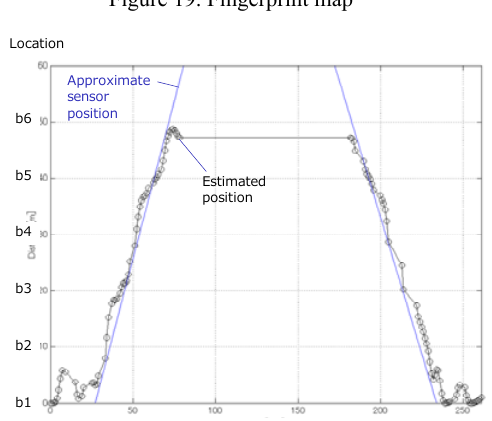
Figure 19. Fingerprint map